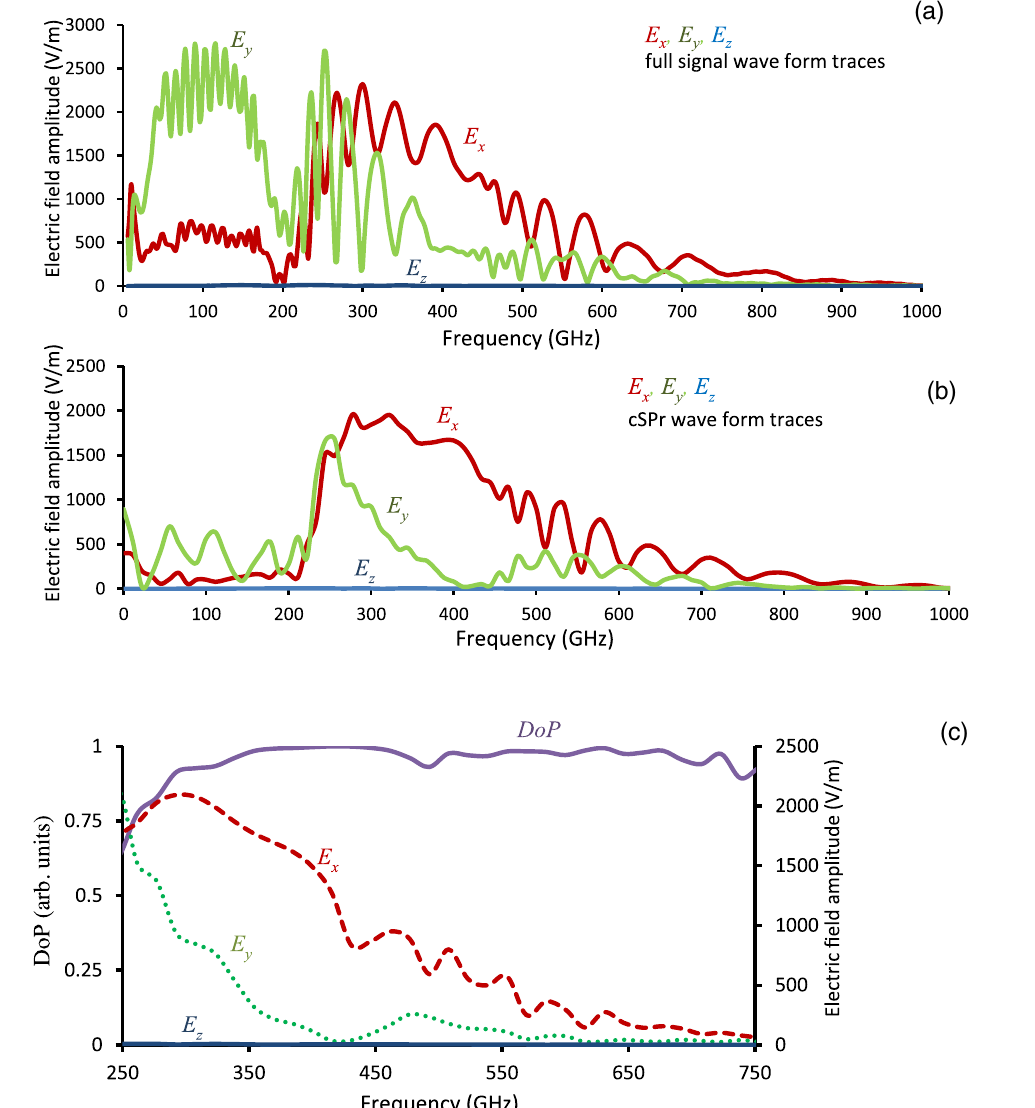
FIG. 5. The results of cSPr DoP studies using 3D PIC MAGIC : (a) the spectra of the field components ( E (b) the spectra of the field components ( E ) of the cSPr signal. The comparison of the spectra of the degree of polarization and the z;x;y cSPr field components is shown in